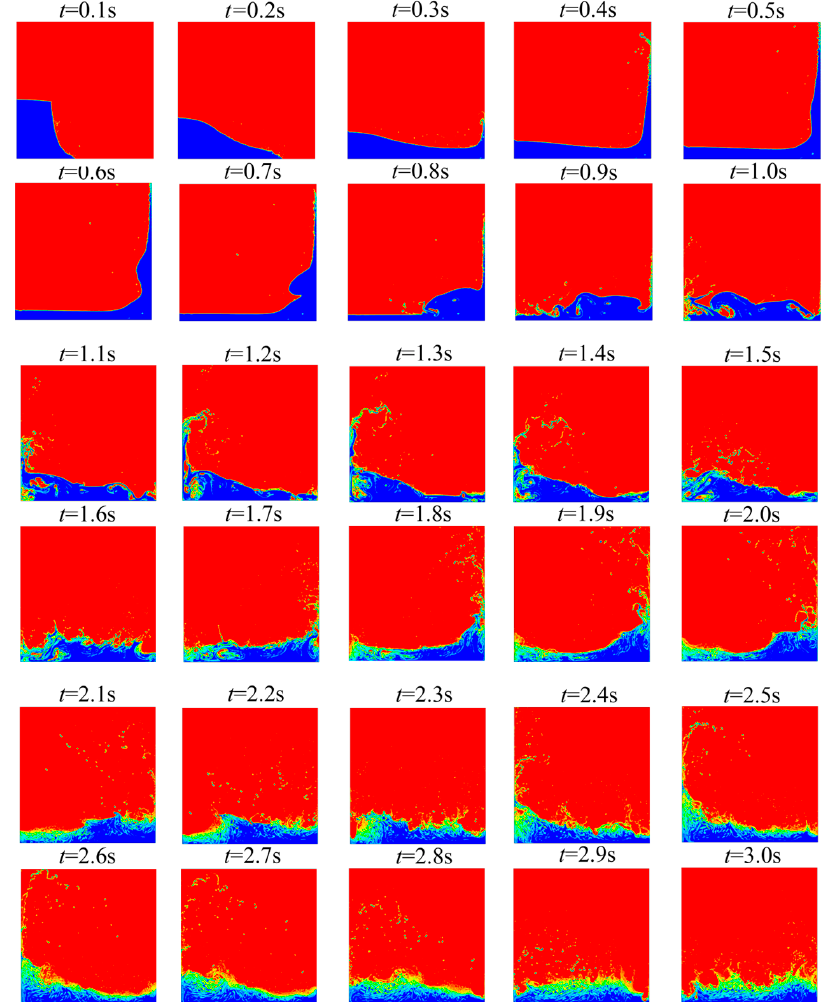
Figure 3. Free surface at typical time in 0~3 s.